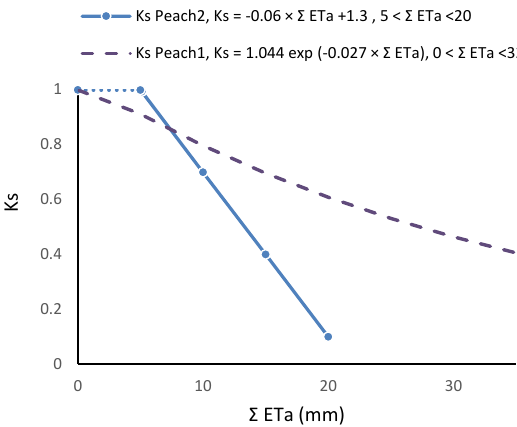
Figure 3. Examples of Ks functions obtained experimentally and their dependence on irrigation method and frequency, influencing the root system; relationship between Ks and Σ ETa in two peach orchards, with similar cultivars, soil, climate and ET rates: dashed line, sprinkler irrigation [81]; full line, daily drip irrigation [80]. Details in Section 8.1.